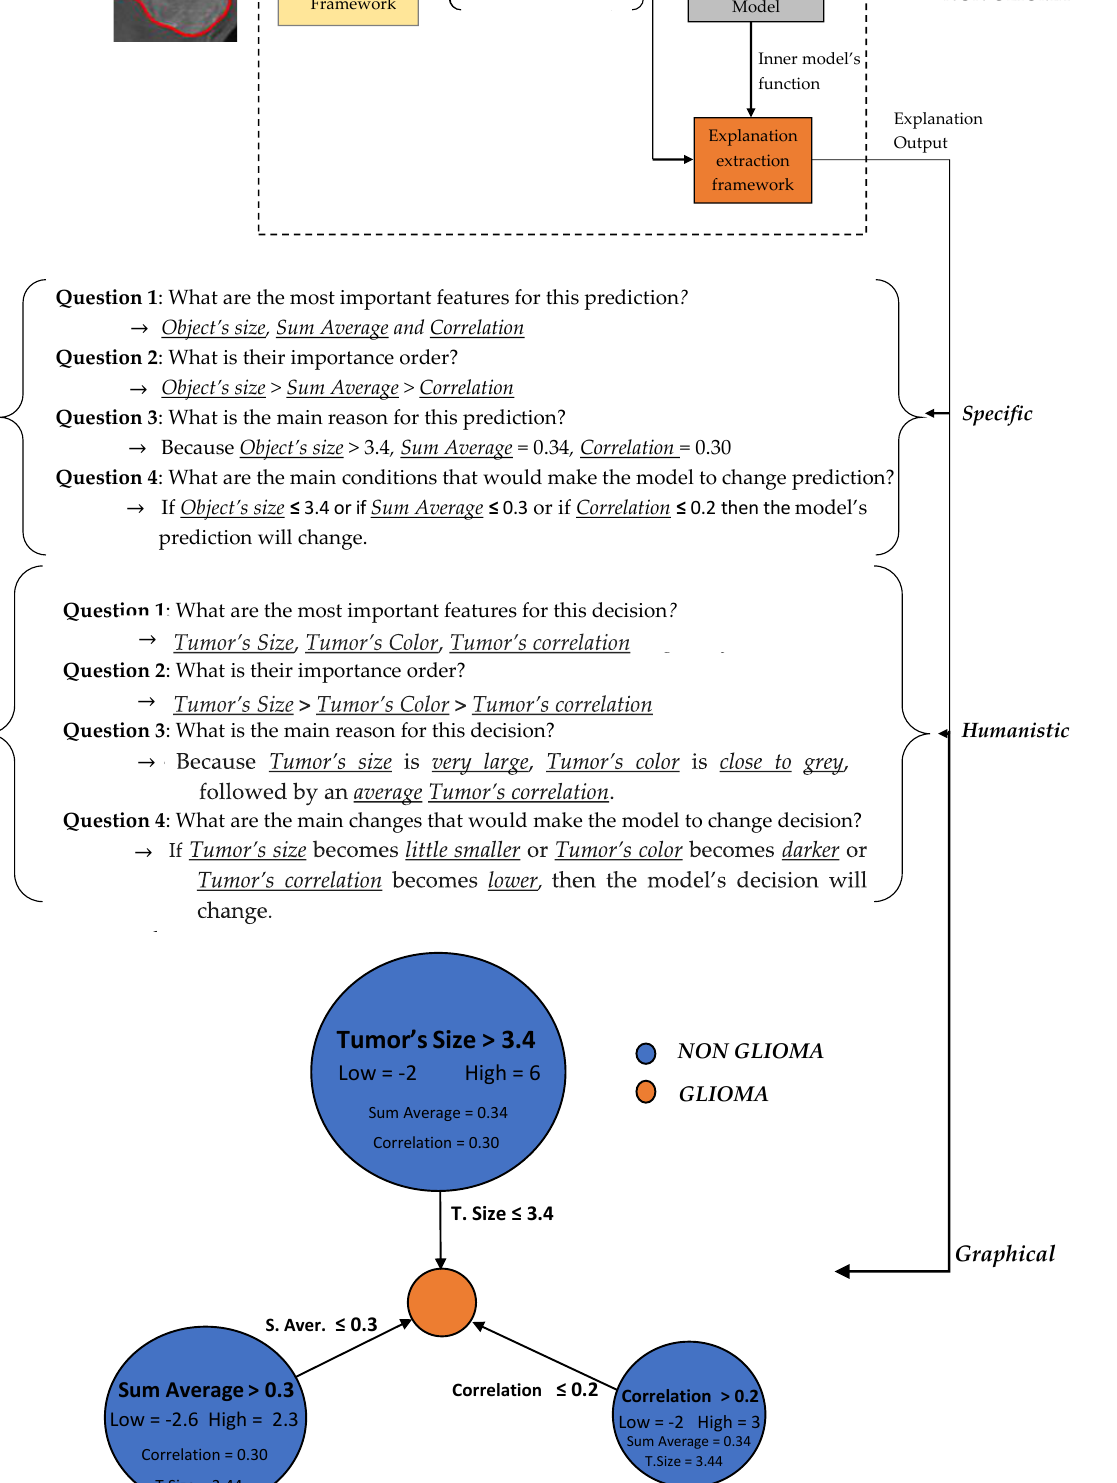
Figure 8. Explanation output for Instance A.